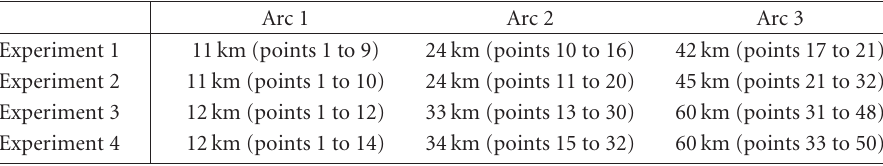
Table 2: Positions of monitoring points for the four SF6